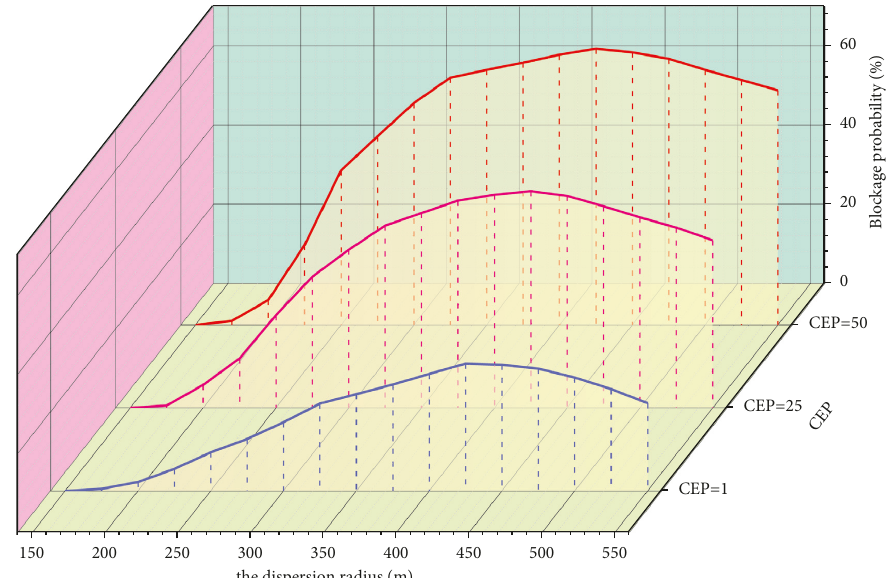
Figure 17: Influence of the dispersion radius of subprojectiles on the blockage probability under different CEP.